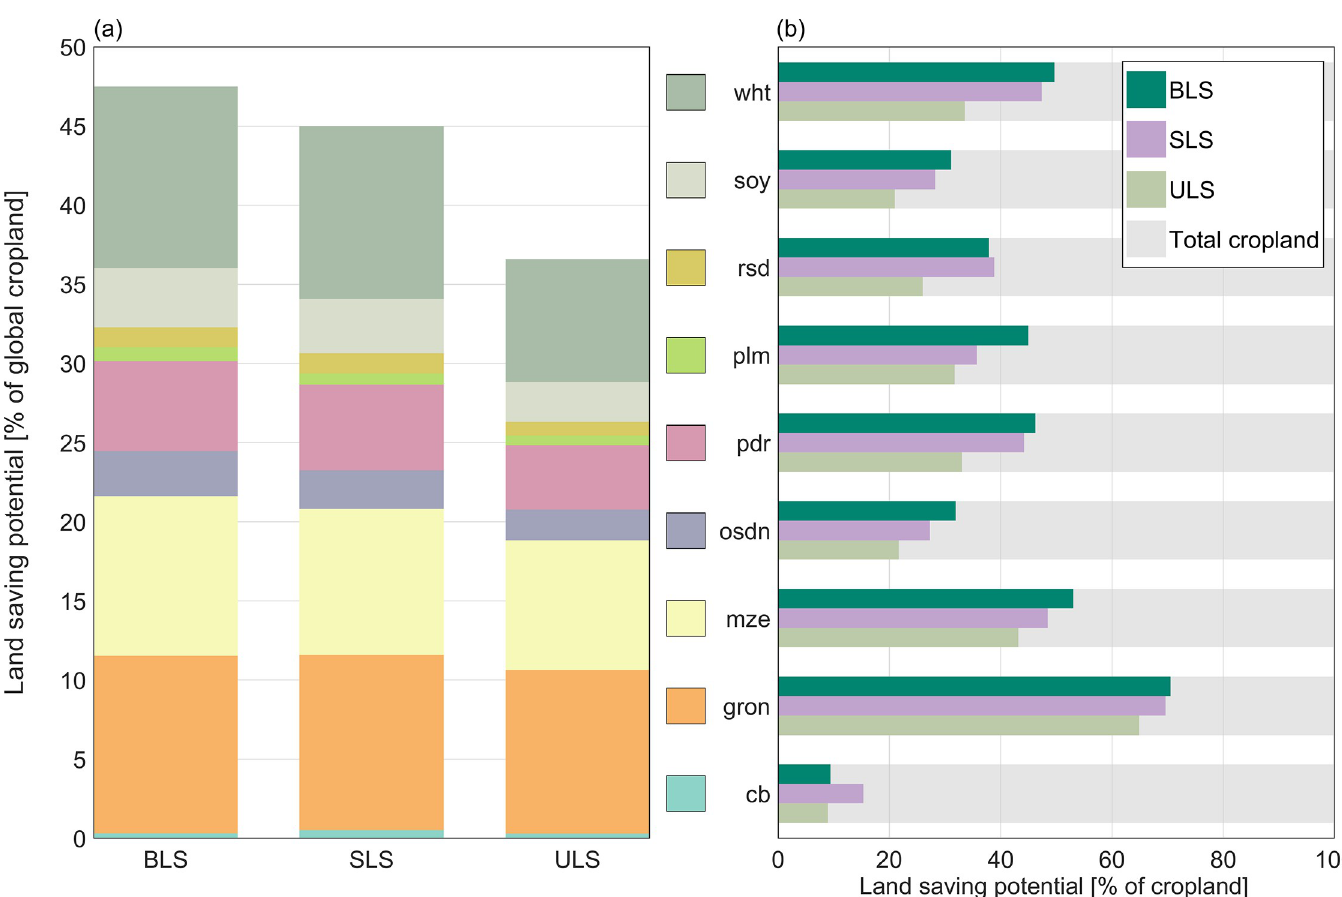
Fig 2. Global land saving potentials. The land saving potential [%] describes the percentage share of cropland that could be taken out of production on the total global cropland area. (a) Global land saving potential for the three different land saving strategies, biophysical land saving (BLS), socio-economic land saving (SLS) and uniform land saving (ULS), further disaggregated into crop categories. (b) Global land saving potential for each crop category as a percentage share of the crop-specific global cropland. For the different crop categories, the following abbreviations are used (Table in S2 Appendix): cb: sugar cane & sugar beet; gron: rest of cereal grains; mze: maize; osdn: rest of oil seeds; pdr: paddy rice; plm: oil palm; rsd: rapeseed; soy: soy; wht: wheat.